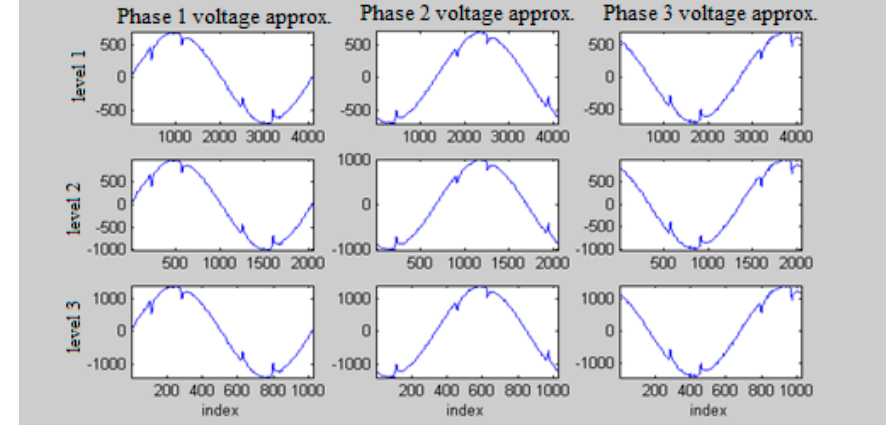
Energies 2022 , 15 , x FOR PEER REVIEW Figure 6. Vectors of approximations for voltages, levels 1–3, first case study.